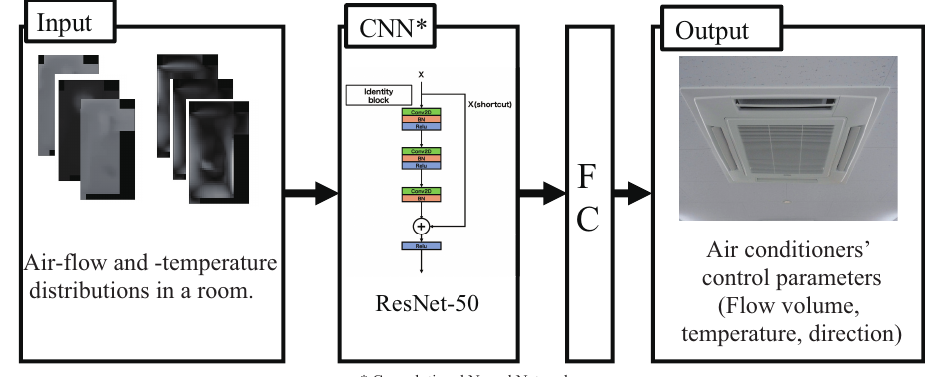
Figure 2. Overall pipeline of our method.